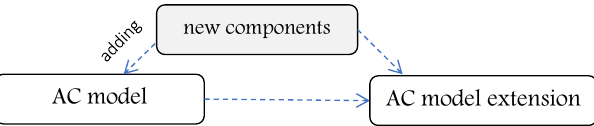
Figure 3. Illustration for AC model extension concept.